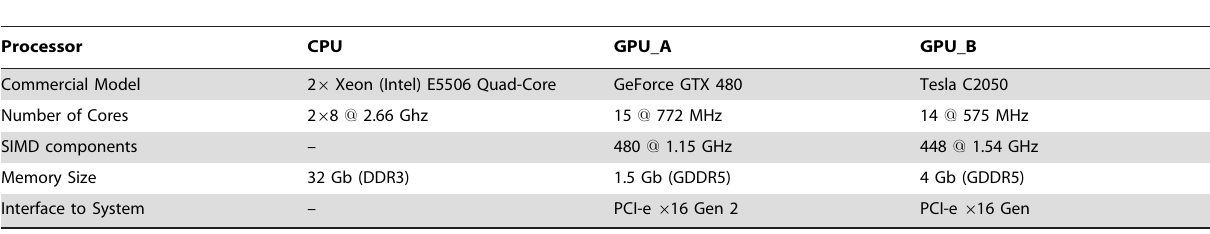
Table 1. Summary of hardware, CPU and GPUs used for running our